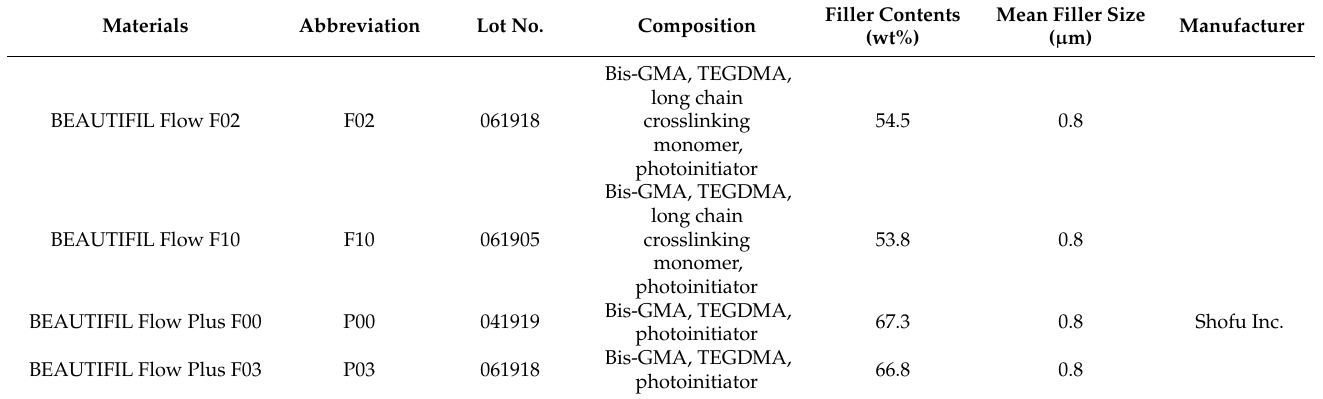
Table 1. Flowable resin composites used in this